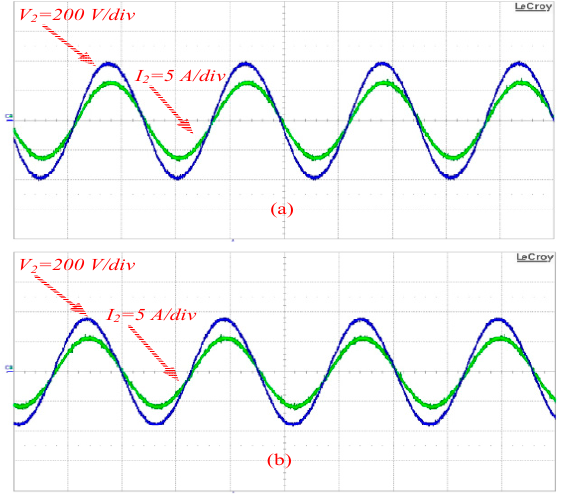
Figure 9. Output voltage and current ( a ) at perfect alignment; and ( b ) at 50% misalignment.